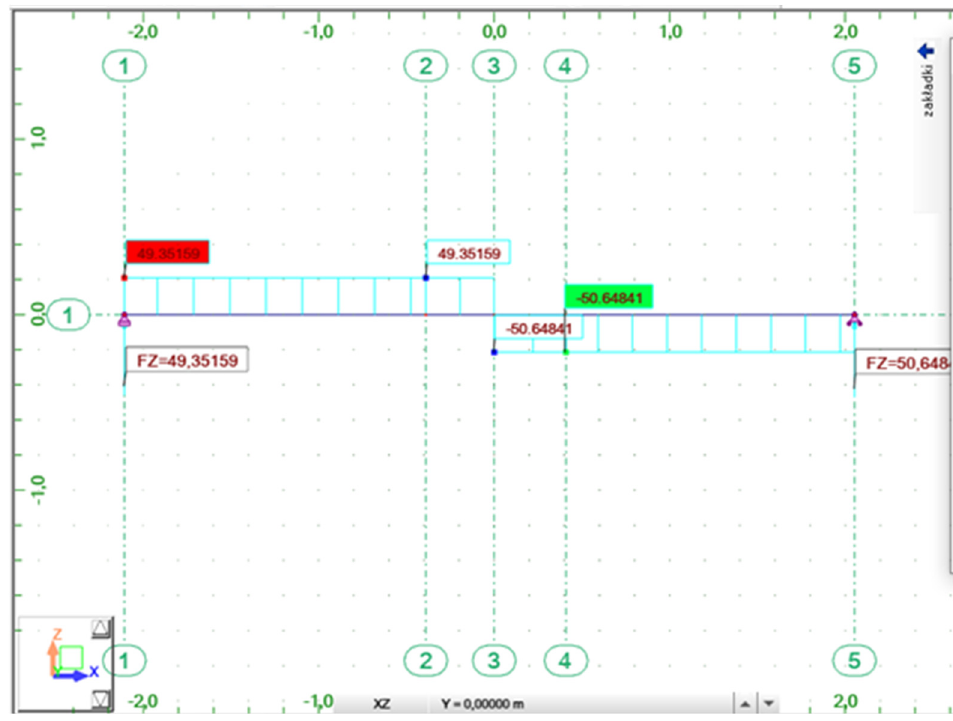
Figure 15. Shear forces of the beam with an increased stiffness in the central part. Point load equal to 100 kN.